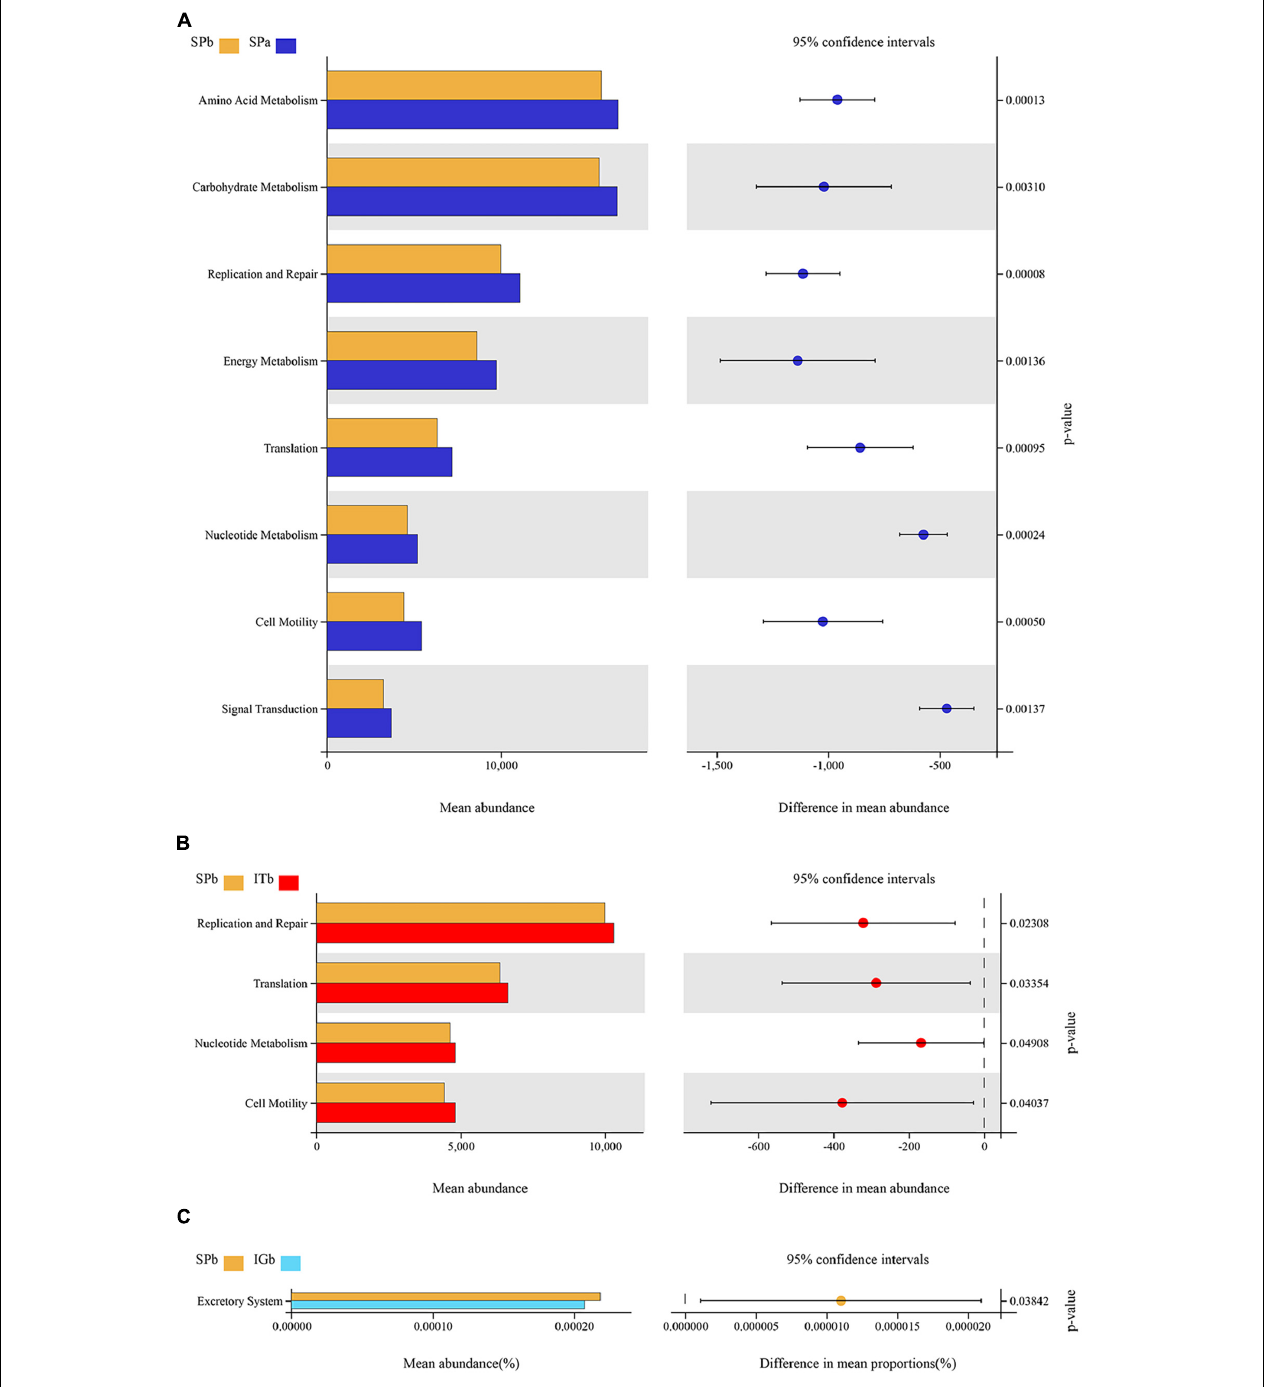
FIGURE 6 | Comparison of the bacterial functions in the soil after continuous cropping with patchouli (A) , after continuous patchouli cropping and intercropping with turmeric (B) , and after continuous patchouli cropping and intercropping with ginger (C) .